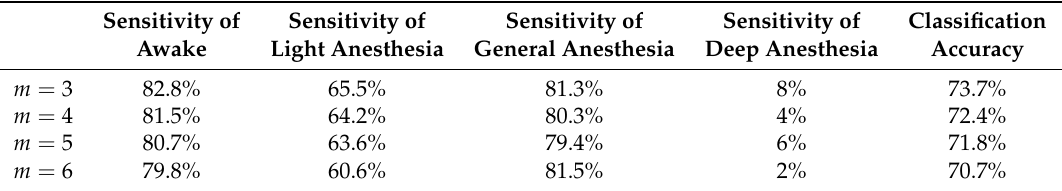
Figure 4. The distributions of PE values with m = 3 to 6. I, II, III, and IV represent awake, light anesthesia, general anesthesia, and deep anesthesia, respectively. Vertical coordinates represent PE values. Table 2. Sensitivity and classification accuracy of PE with different embedding dimension m